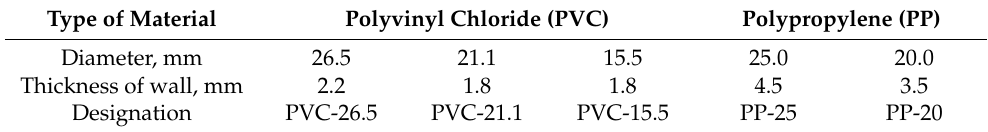
Table 1. Dimension of polymer